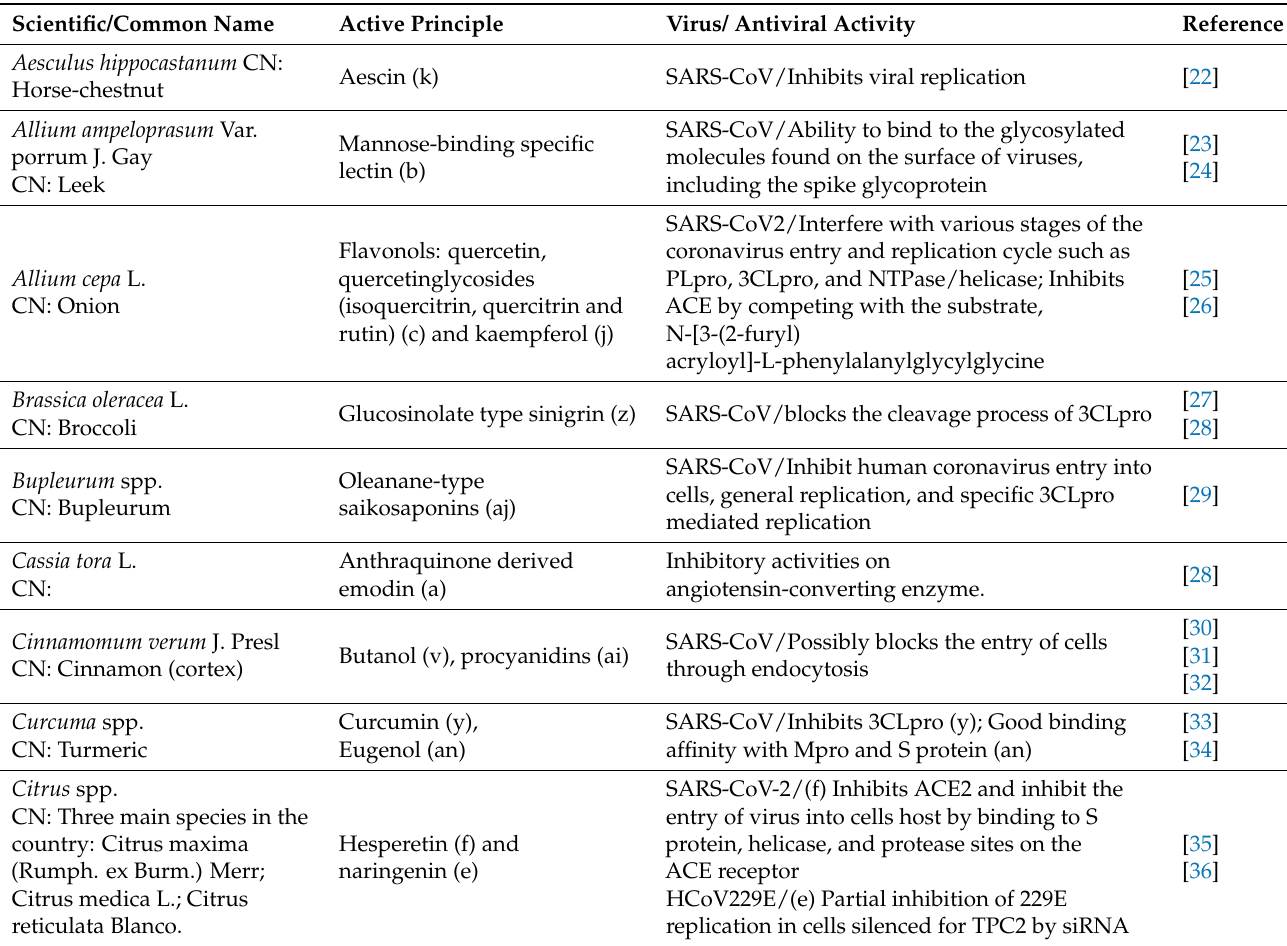
Table 2. Medicinal plants and natural products with inhibitory activity against various types of coronaviruses. Scientific/Common Name Active